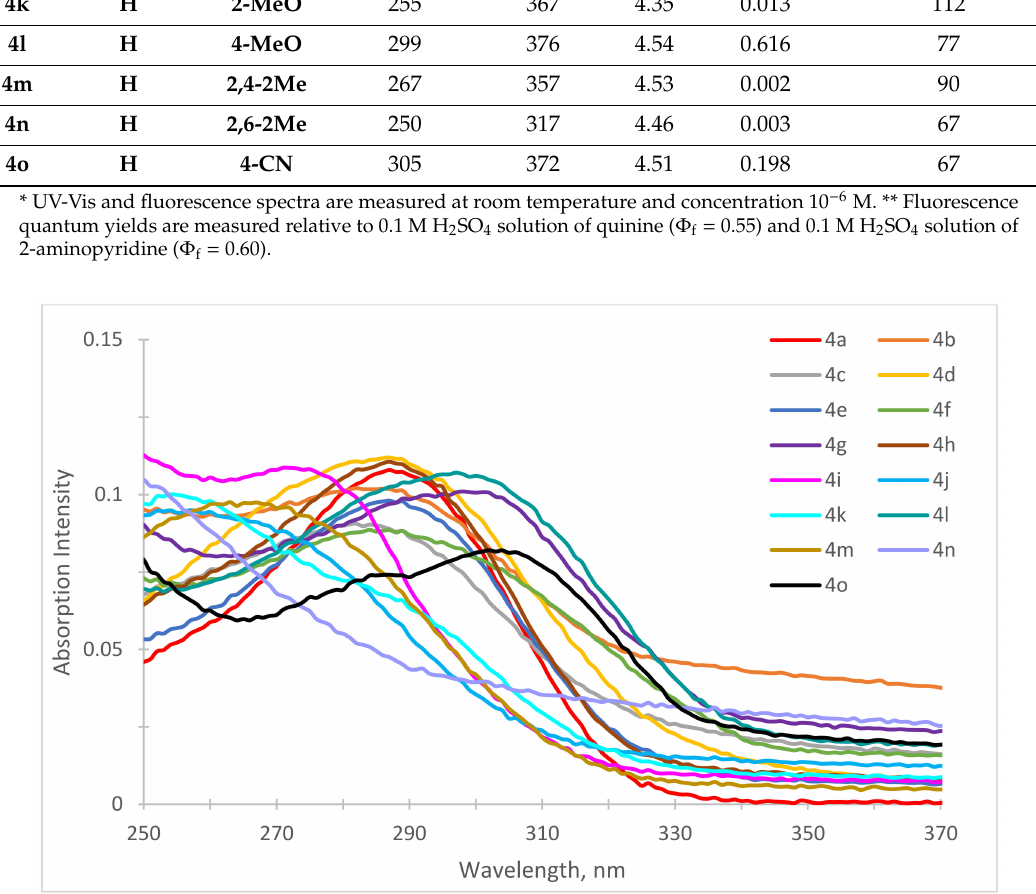
Figure 6. Absorption spectra of 4a – 4o in dichloromethane at room